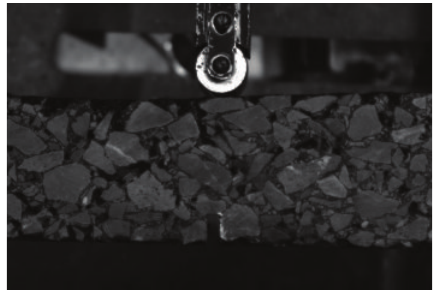
Figure 5: Asphalt mixture with coarse